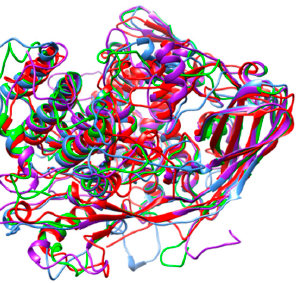
Figure 6. Multiple amino acid sequence alignment of hexamerins from Locusta migratoria ( Locusta m .), Apis mellifera ( Apis m .), Tenebrio molitor ( Tenebrio m .) and Galleria mellonella ( Galleria m .). Identical amino acids are displayed in white letters highlighted in blue, homologous amino acids are displayed in black letters highlighted in cyan, and putative N -glycosylation sites are highlighted in red.